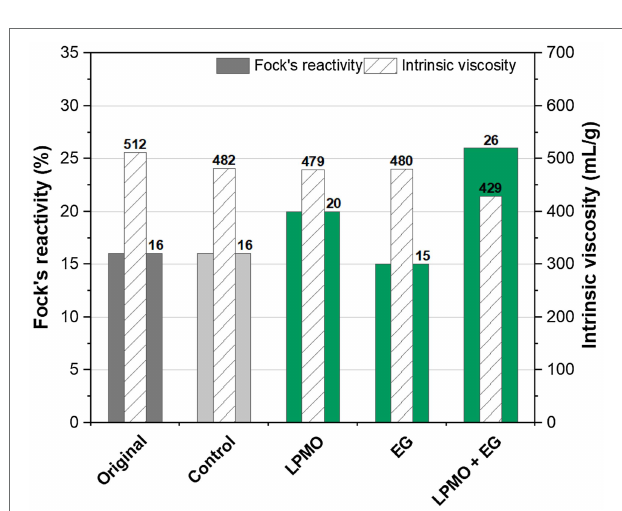
FIGURE 4 | Fock’s reactivity and viscosity of a viscose-grade dissolving pulp treated with a GH45 endoglucanase (EGs) and an AA9 LPMO. The original pulp was not treated, and the control pulp was treated under the same conditions but without enzymes. The treatment was carried out at pH 5 in 50 mm acetate buffer for 25.5 h.